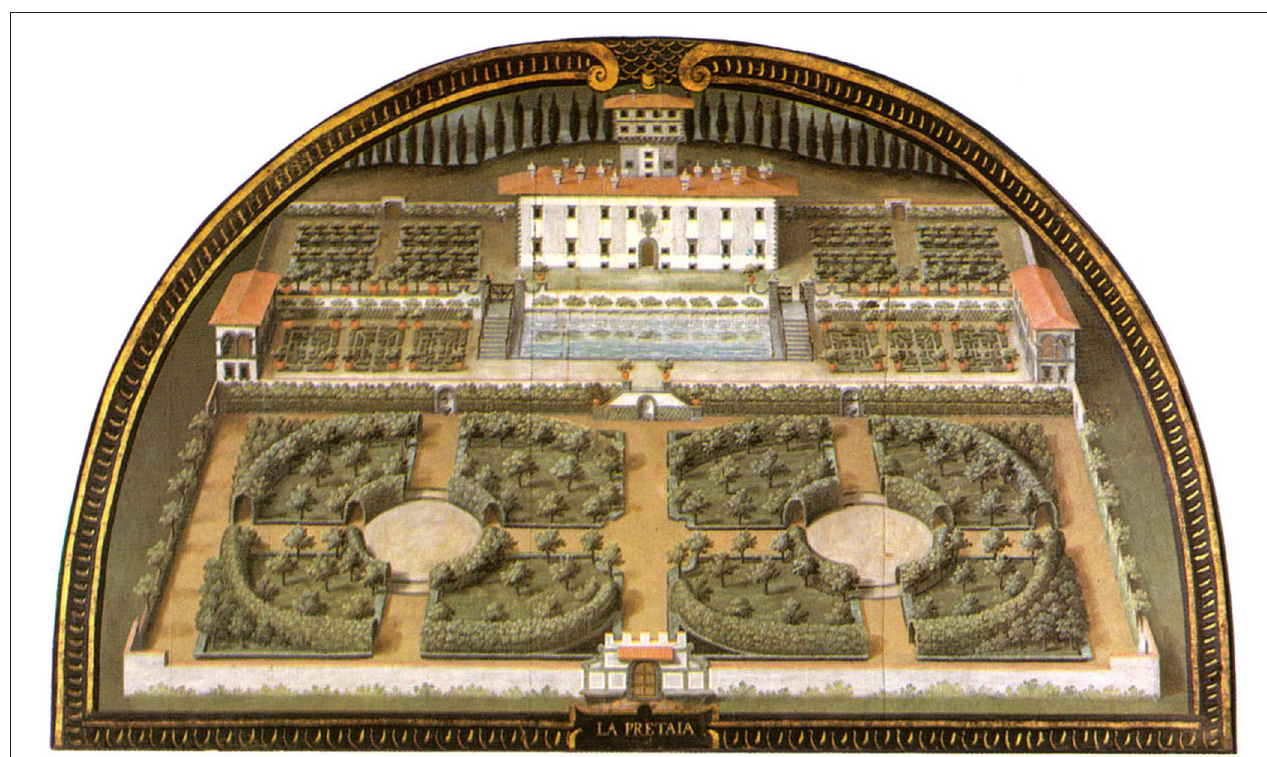
FIGURE 1 | Villa “La Petraia” at Castello, near Florence, in a lunetta painted by Flemish Justus Utens between 1599 and 1602. Built in the sixteenth century as private estate of the Grand Dukes of Tuscany, the villa became property of the Italian state in the twentieth century and the park is now open to citizens and visitors (this picture is a public domain free of